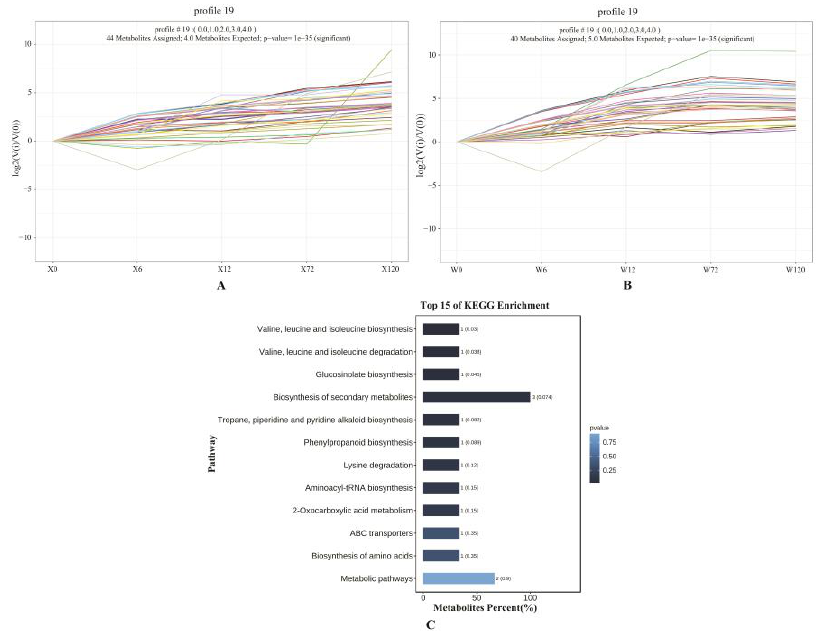
Figure 7. Trend analysis of DMs in drought-tolerant genotype ( A ) and drought-sensitive genotype ( B ); ( C ): KEGG enrichment of DMs in profile 19, which was specific to drought-tolerant genotype.